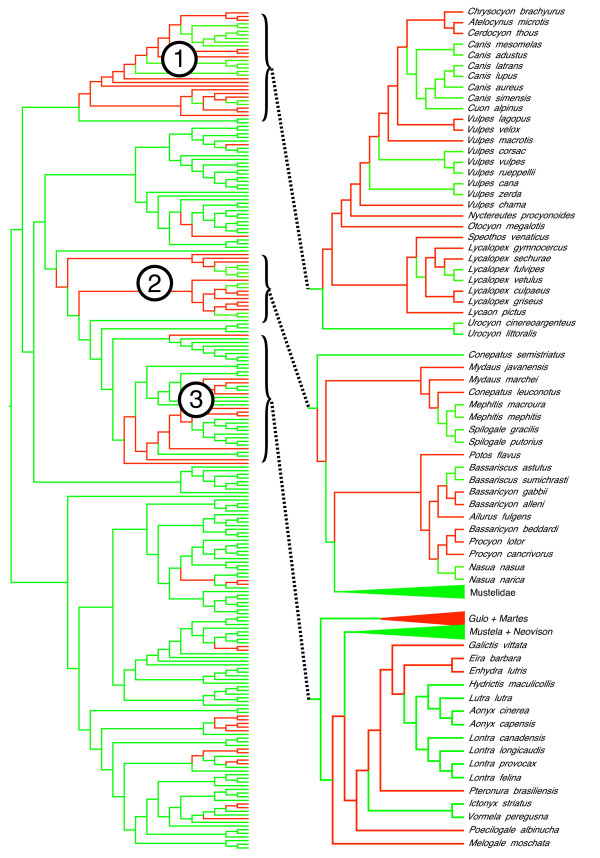
Phylogenetic relationships among Carnivora as inferred from a partitioned maximum likelihood supermatrix analysis. The tree includes all 229 carnivore species for which molecular sequence data from the 74 gene data sets were available from GenBank. Taxon names have been omitted for clarity and the orientation of the tree parallels that in Figure 2 as far as possible. Green branches indicate clades also occurring on the full matrix representation parsimony supertree, whereas red branches indicate conflicting clades; branch lengths do not reflect divergence times or amount of sequence divergence. Most of the conflict between the two trees derives from three unusual results from the supermatrix analysis: 1) a paraphyletic Vulpes nesting within Canini within Canidae, 2) a paraphyletic Mephitidae and Ailurus fulgens nesting within Procyonidae, and 3) a placement of Eira barbara away from Gulo + Martes and within Lutrinae.